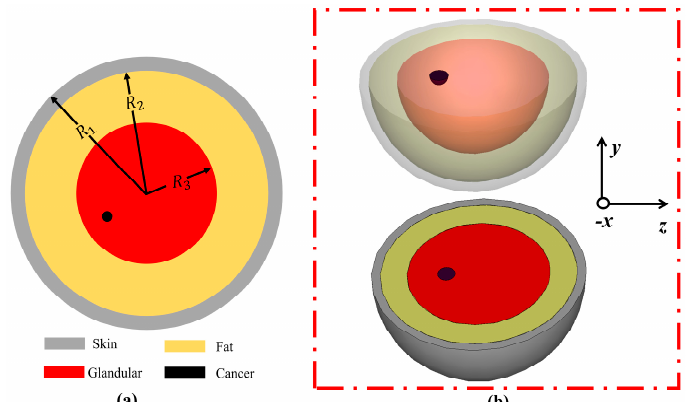
Figure 15. ( a ) Hemispherical breast model. ( b ) Simulated 3D breast phantom model in CST Studio Suite simulator.